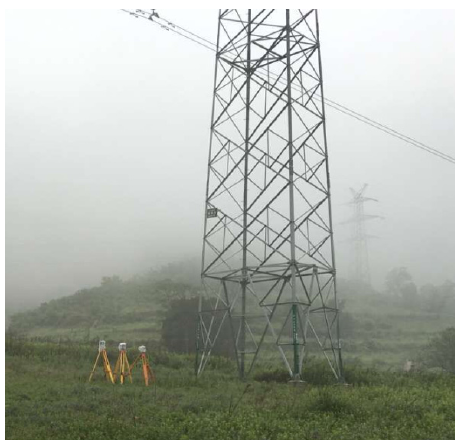
Figure 4. GPS station TB06 under high-voltage transmission line environment (the latitude and longitude of station TB06 are 34 ° 08 ′ 01 ″ and 107 ° 54 ′ 38 ″ , respectively).